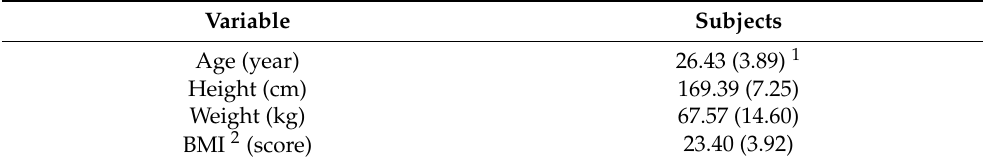
Table 1. General characteristics of the